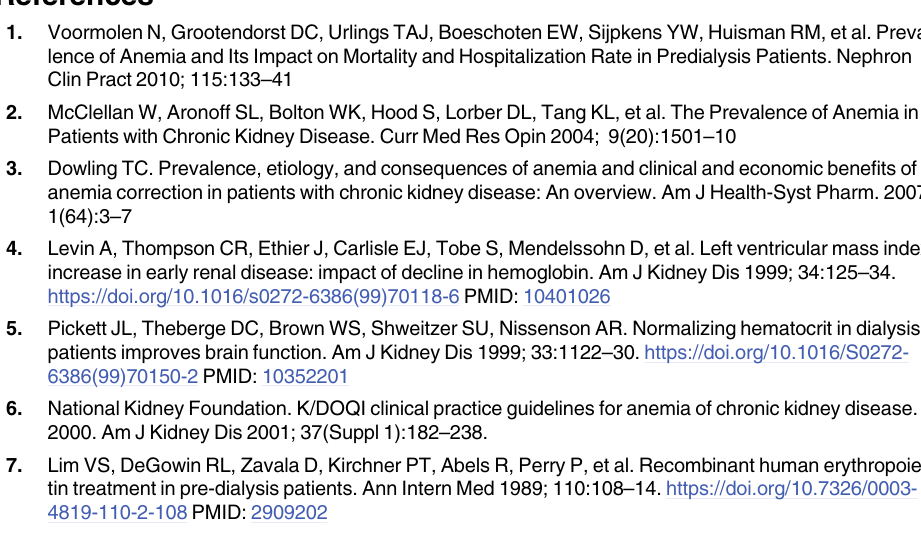
S1 Table. Baseline characteristics of the patients grouped according to the presence of severe